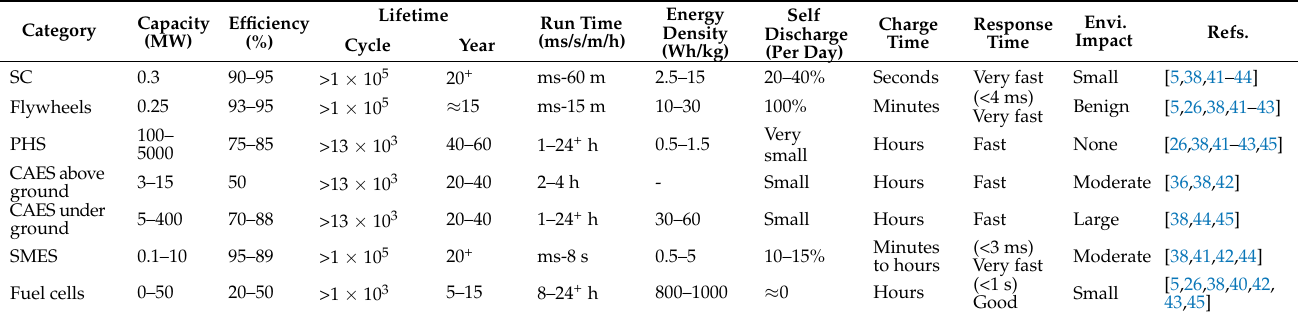
Table 1. Comparison of different features of the main